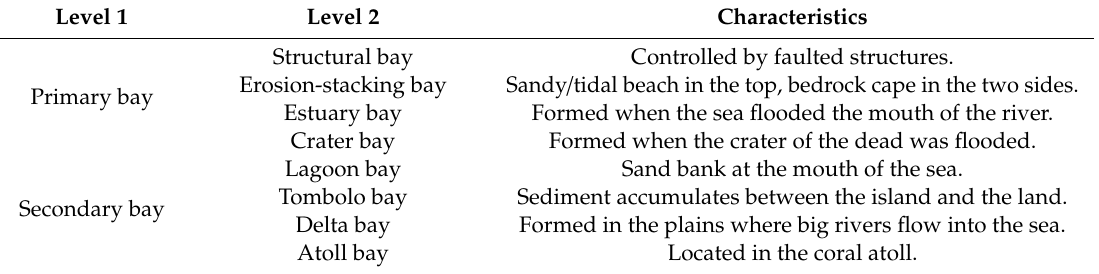
Table 1. The bay category [40].